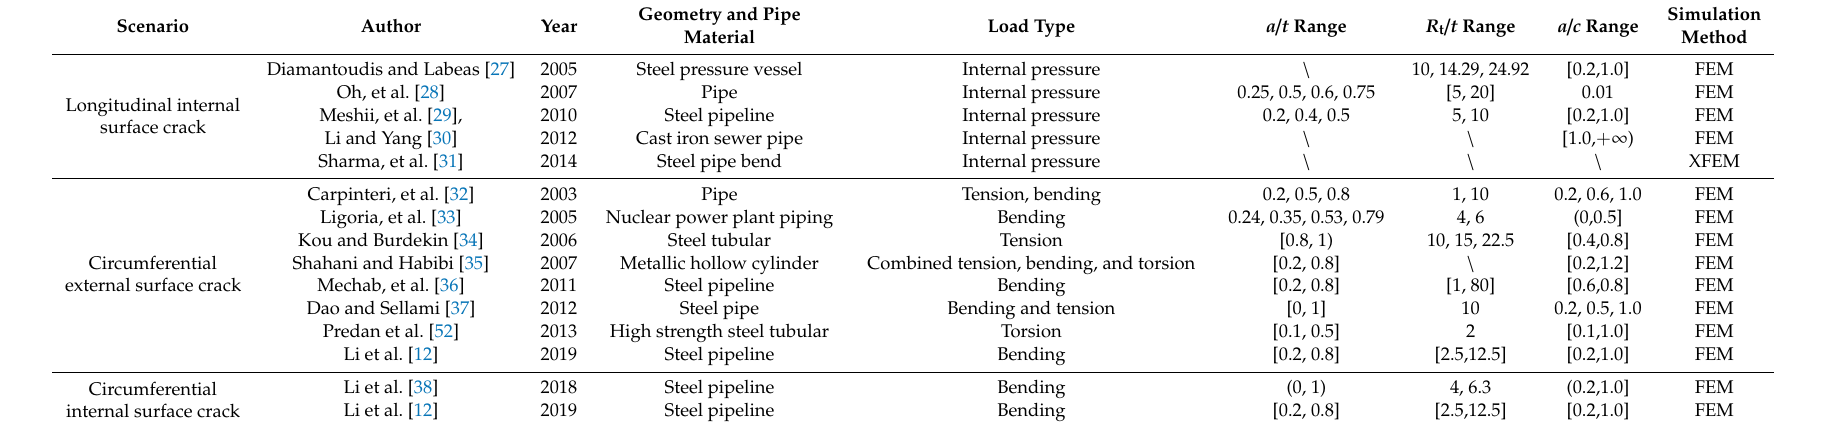
Table 3. Numerical simulations conducted on surface cracked metallic